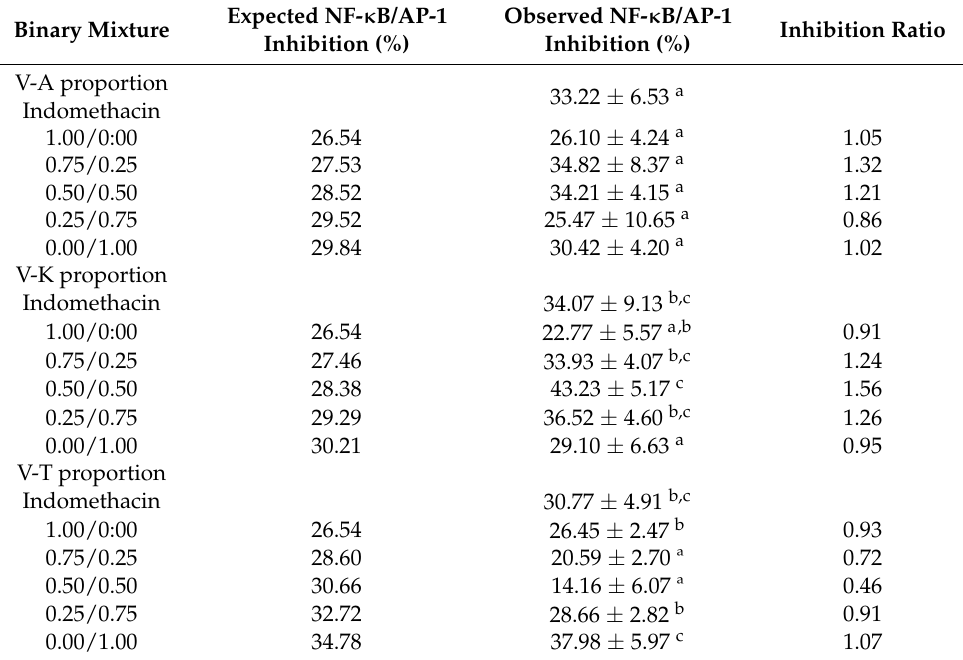
Table 3. Fixed proportions scheme of verbascoside-aucubin, verbascoside-kobusin, and verbascoside- tenuifloroside binary